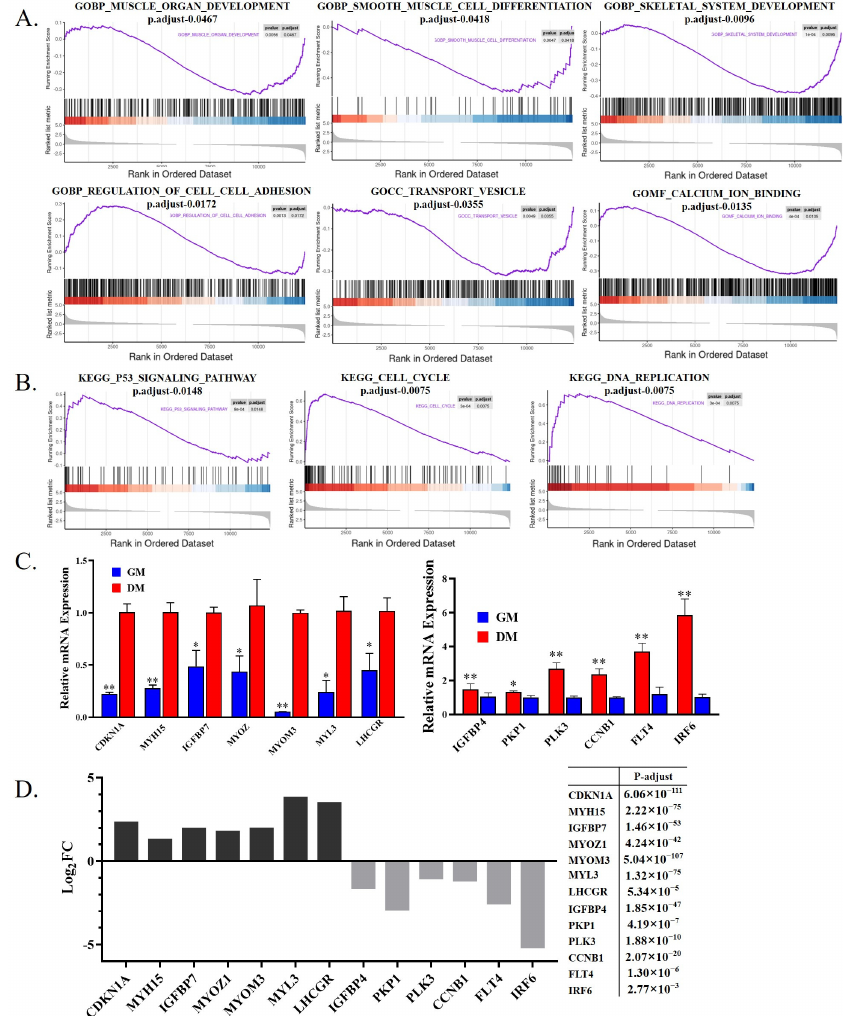
Figure 3. A g ene set enrichment analysis of DEGs between Shitou goose myoblasts and myotubes. ( A ) Significantly enriched Gene Ontology terms by GSEA analysis; ( B ) significantly enriched KEGG pathways by GSEA analysis; ( C ) qPCR validation of some DEGs involved in muscle development; ( D ) RNA-seq results of some DEGs involved in muscle development. The data in C are mean ± S.E.M. with three replicates per group. One-sample t- test was used to assess the difference between the two groups. * p < 0.05; ** p < 0.01.